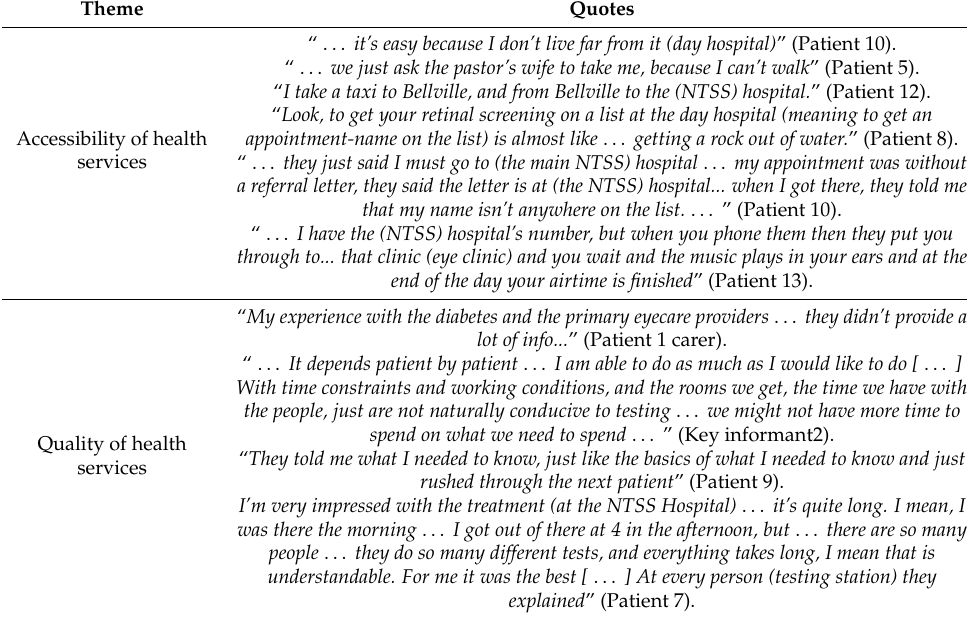
Table 3. Socioeconomic and environmental